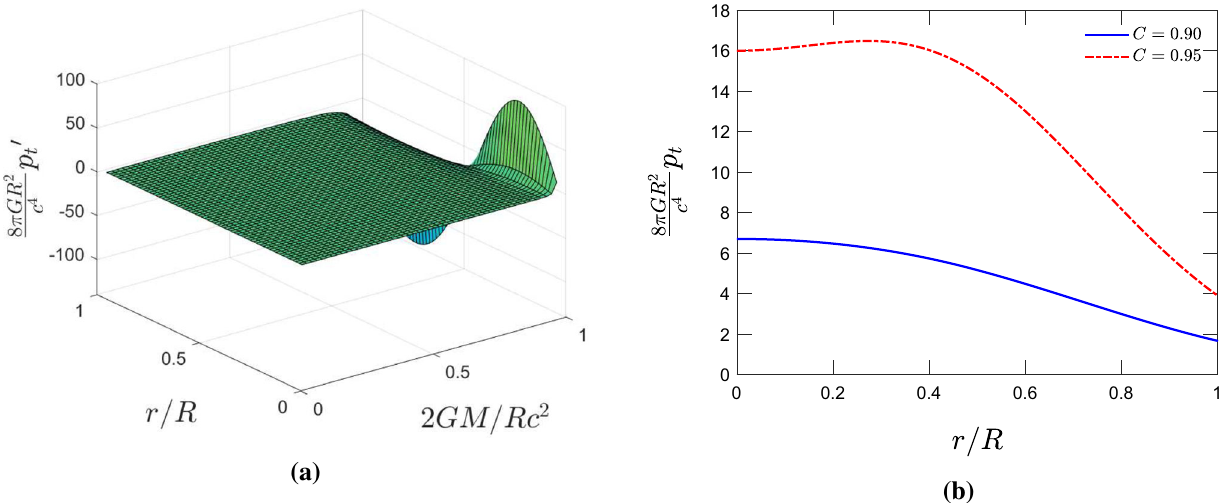
Fig. 2 a Thederivativeof p t withrespecttocompactness2 GM / Rc 2 ofastaranddistance r / R fromitscenter.Itisevidentthatforhighcompactness values, p t is not monotonically decreasing. b The tangential pressure p t with respect to the distance from the center of the star for two compactness values